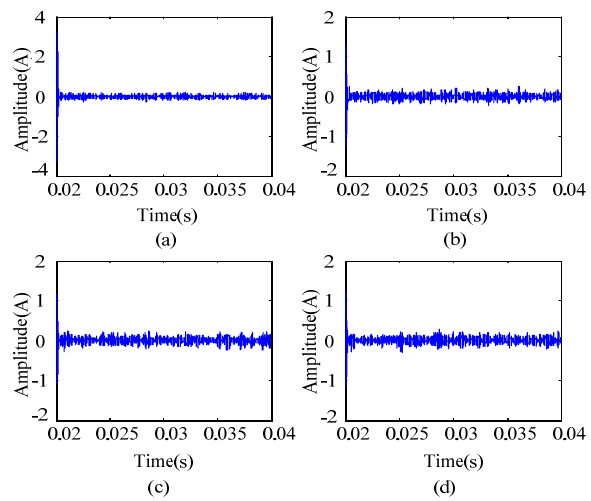
Figure 10. IMF3 components of each outgoing line. ( a ) Lian L 1 ; ( b ) Lian L 2 ; ( c ) Lian L 3 ; ( d ) Lian L 4 . Energies 2020 , 13 , x FOR PEER REVIEW